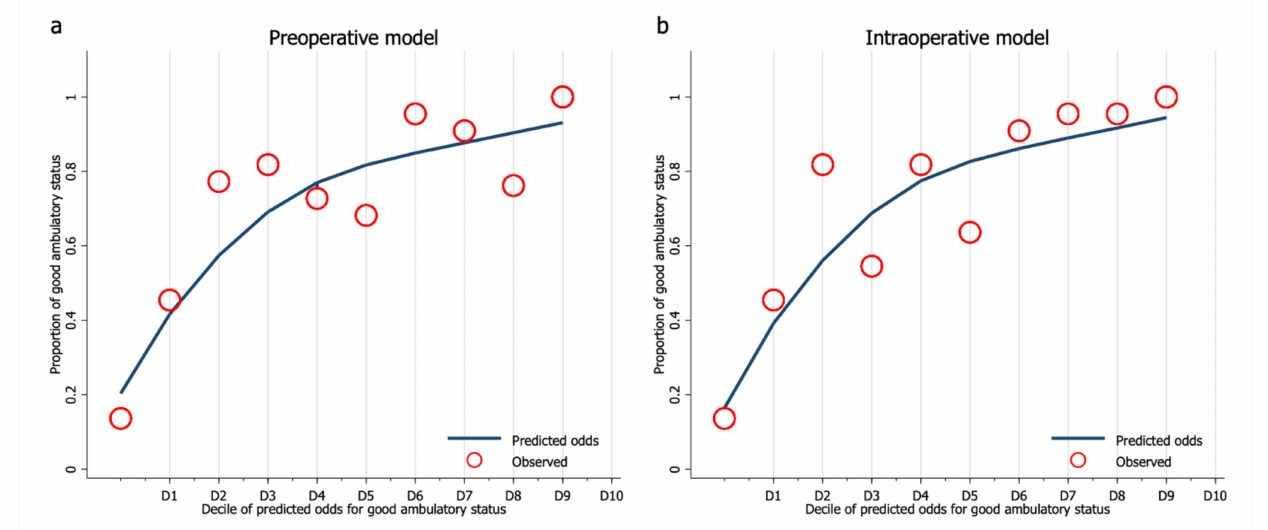
Figure 3. Calibration plot between an observed odds and decile divided predicted odds of ( a ) the preoperative model and ( b ) the intraoperative